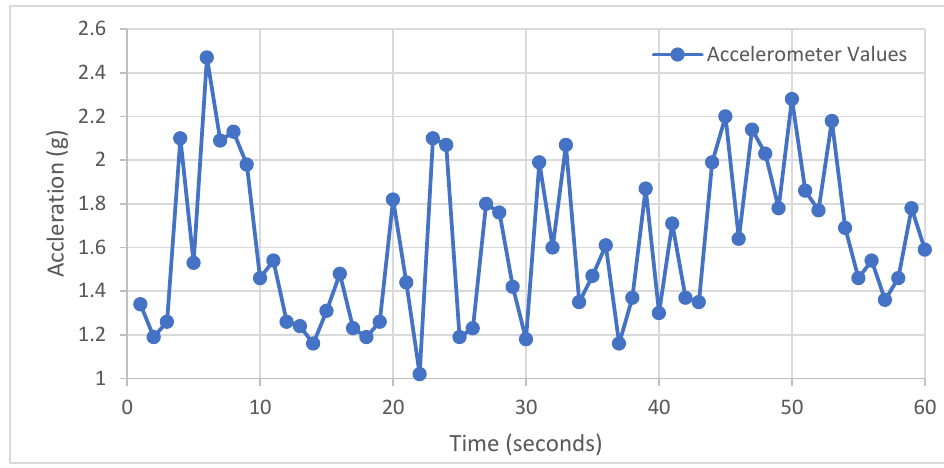
Figure 5. Physical exercise .